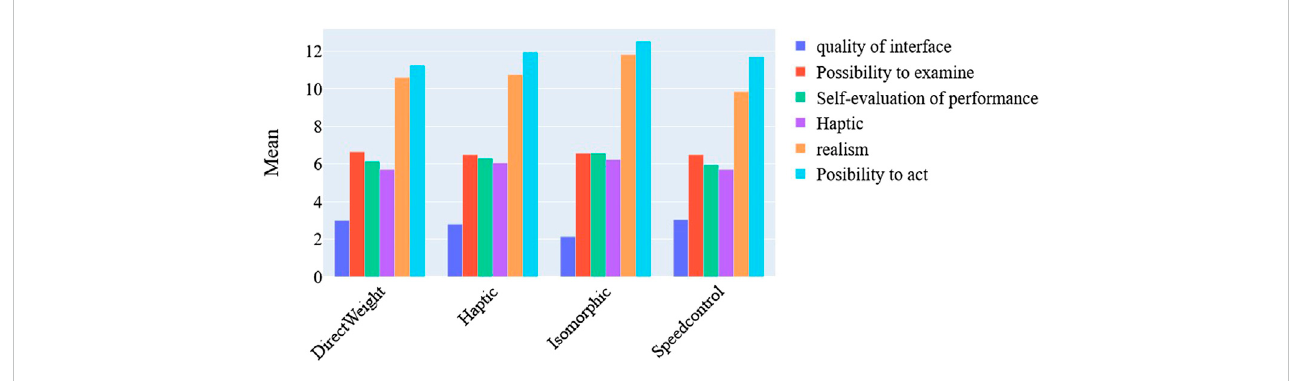
FIGURE 10 Presence questionnaire: Mean of responses of 20 users to measure the different features of presence questionnaire, completed by users after each condition.